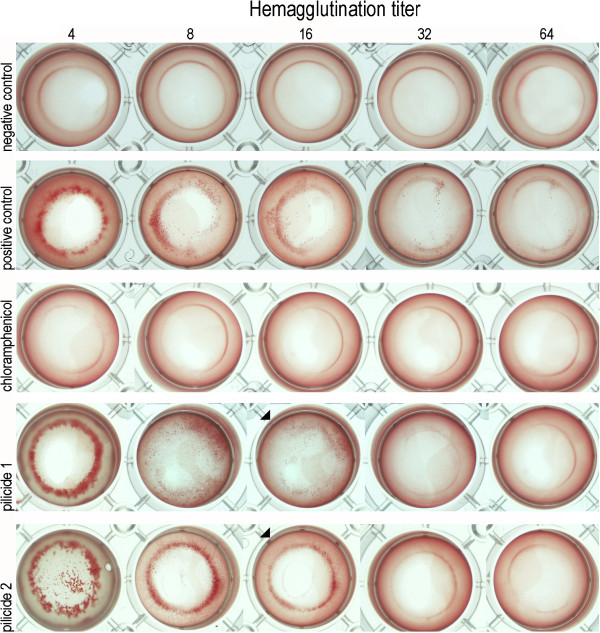
Blocking of Dr fimbriae-dependent agglutination of human erythrocytes by pilicides. The following bacterial preparations, normalized to OD600, were used in the hemagglutination assays: negative control – E. coli BL21DE3/pACYC184, grown on TSA plates with 5% DMSO, non-fimbriated strain; positive control - E. coli BL21DE3/pBJN406, grown on TSA plates without pilicide, fully-fimbriated strain; chloramphenicol –E. coli BL21DE3/pBJN406, grown on TSA plates without pilicide, the agglutination experiment was performed in the presence of 2 μM of chloramphenicol; pilicide 1 and pilicide 2 - the E. coli BL21DE3/pBJN406 grown on the TSA plates in the presence of 3.5 mM of agents 1 and 2, respectively. HA titer represents two-fold serial dilutions of normalized bacterial suspensions. The initial 1, 2 and final 128 dilutions are not presented. In the case of HA assays with bacteria cultivated in media in the presence of pilicide the black triangles mark the highest dilution which still provides visible agglutination.